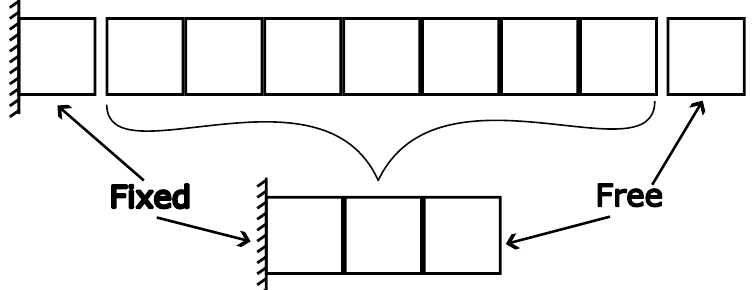
Figure 6. Reduction of a full-length actuator to its simplest representation. All units with unique boundary conditions remain in the reduced representation. Units with similar boundary conditions are condensed into a single unit representative of the group